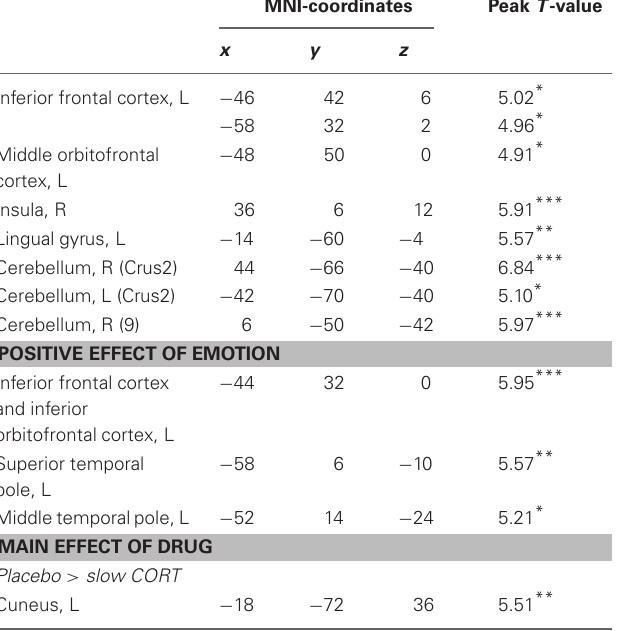
Table 2 | Peak voxels and corresponding T values of significantly activated clusters in main effects of task, emotion, and